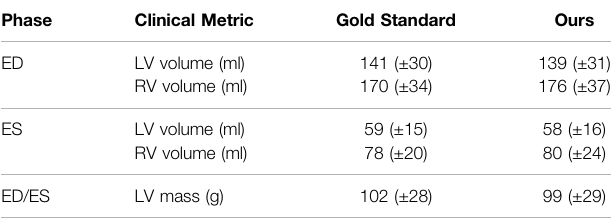
TABLE 4 | Clinical metrics ofmeshed EDand ESanatomy point clouds generated by our